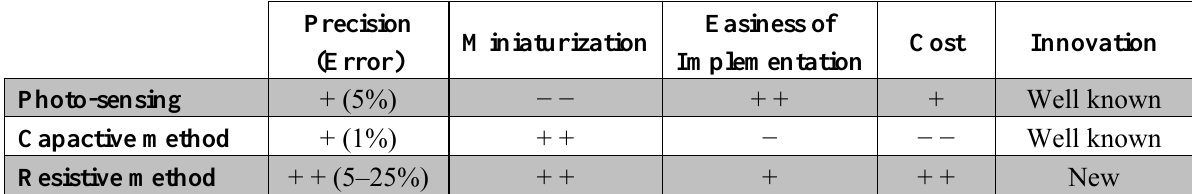
Table 1. Comparison of the three measurement